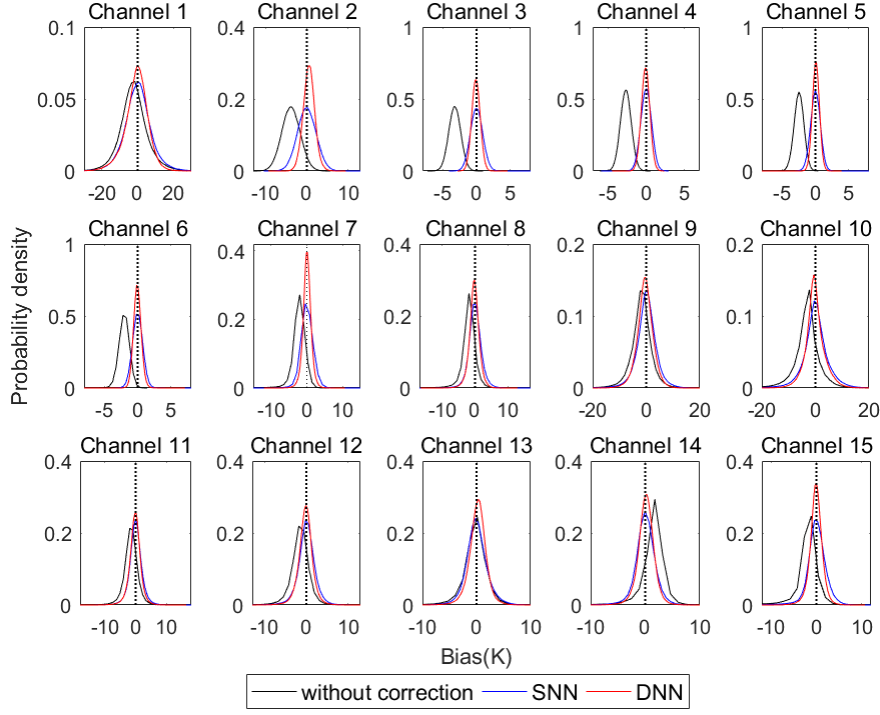
Figure 7. Probability density distribution of observation bias before and after bias correction.